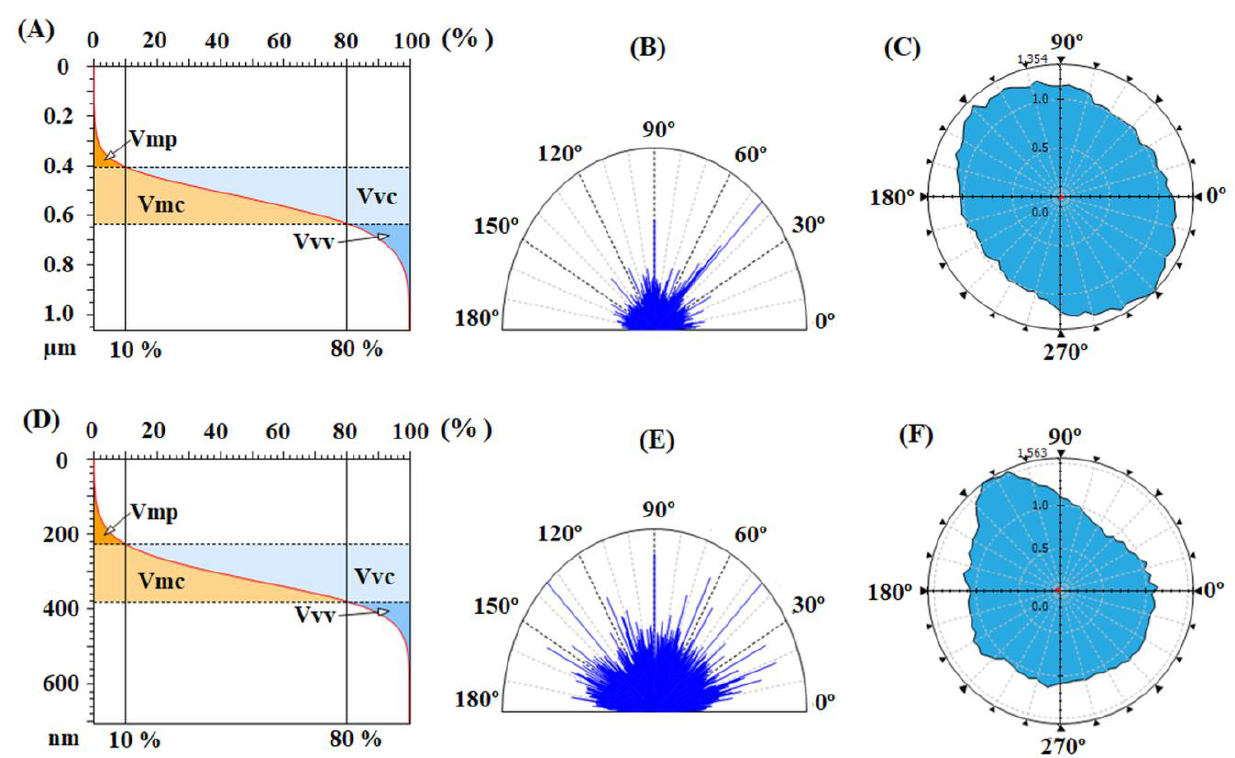
Figure 11. Abbott–Firestone curves with functional volume parameters, texture direction representations and graphs with polar coordinates to analyze orientation with azimuth angle obtained for DBD plasma-treated rubbed EPI-pBAPS (3R) ( A – C ) and CBDA-pBAPS (3R) ( D – F ) samples.